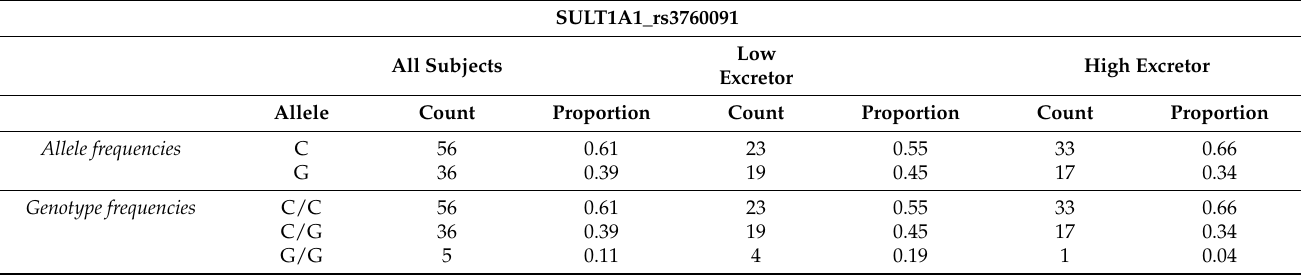
Table 5. Genotypes and allele frequencies of SULT1A1_rs3760091 polymorphism in studied